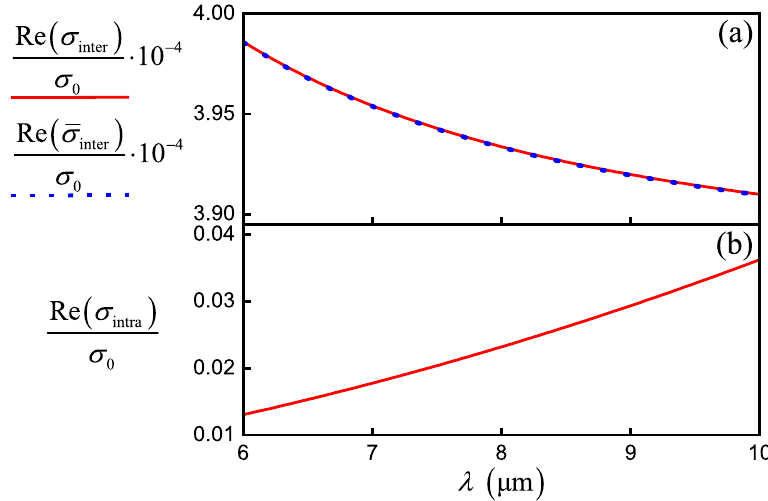
Figure 2. ( a ) The dependence of interband conductivity σ inter (solid red line) and Pade approximation σ inter (dotted blue line) normalized to σ 0 on the wavelength. ( b ) The dependence of intraband conductivity σ intra normalized to σ 0 on the wavelength, µ c = 0.6 eV, τ = 0.9